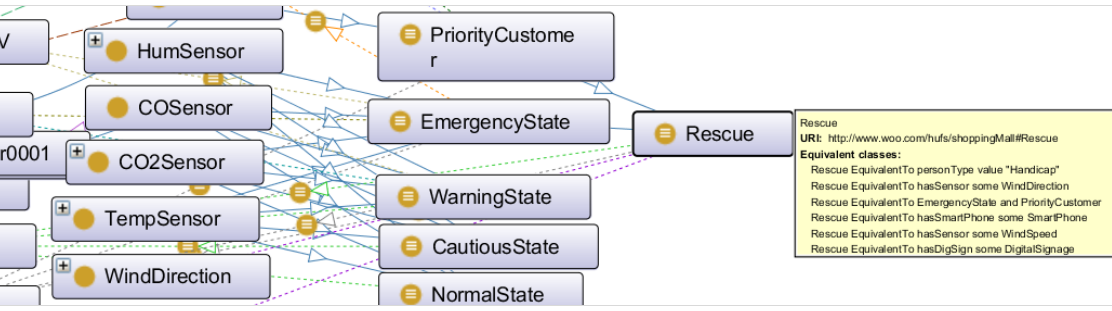
Figure 22. Representation of CVO for service creation.